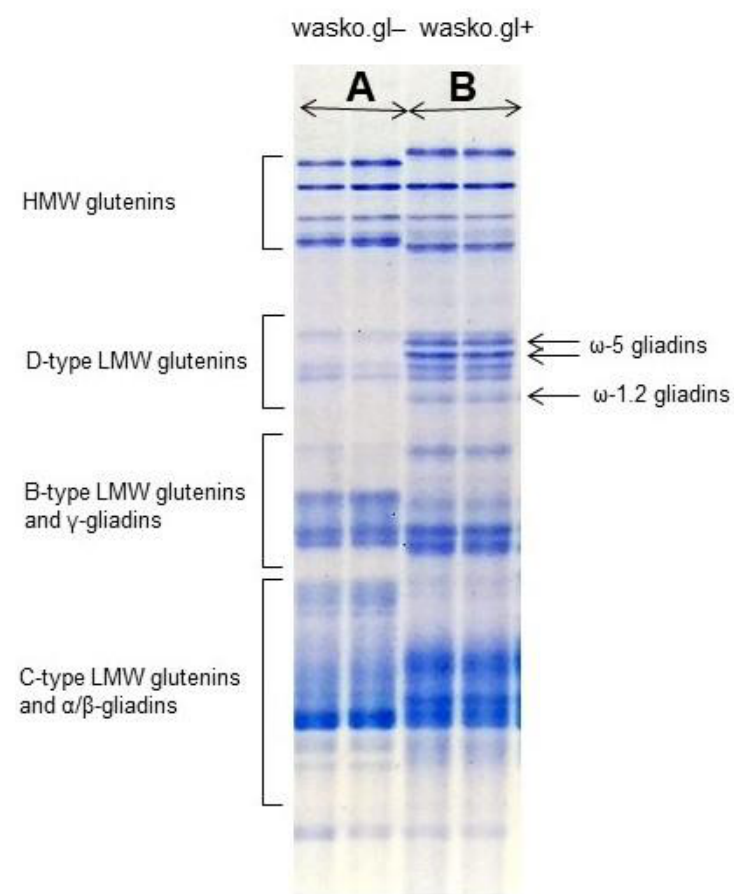
Figure 2. The ω -gliadins present in wasko.gl+ wheat control line, part ( B ), illustrated on the back- ground of total proteins extracted from the endosperm of wheat kernels and separated by SDS- PAGE. ω -gliadins share the common electrophoretic zone together with D-type LMW glutenins. In wasko.gl – , ω -gliadins deficient wheat line, only D-type LMW glutenin subunits can be observed in this zone (separations on the left-hand side of the electropherogram, part ( A ). Different mobilities in HMW glutenins are due to a different genetic background of wasko.gl+ and wasko.gl – . Wasko.gl – contains allele on 1B chromosome coding for 5 + 10 subunits although wasko.gl+ contains that for 2 + 12 subunits.